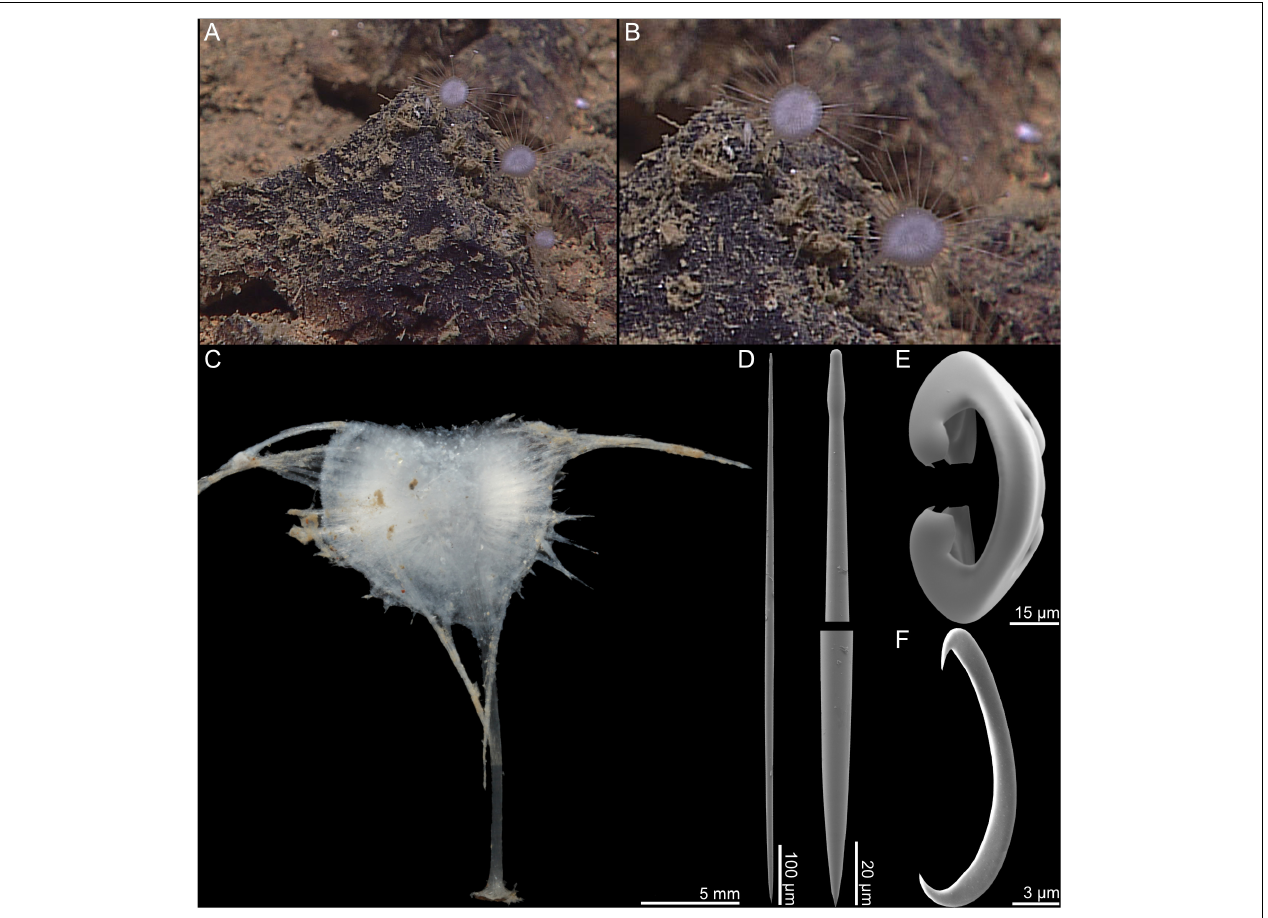
FIGURE 2 | Abyssocladia fryerae n. sp. (A,B) In situ images from ROV video, (C) complete recovered specimen, (D) subtylostyle with elongated tyle, (E) arcuate isochela, and (F)